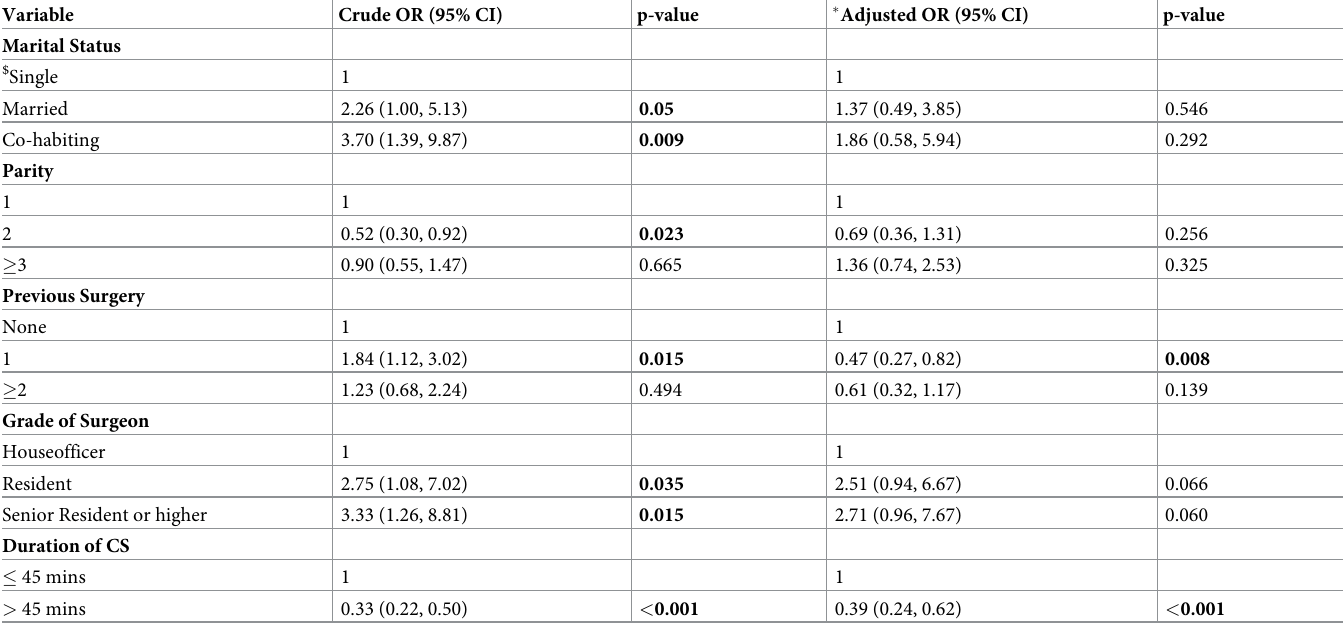
Table 4. Logistic regression analysis output for association with pain scores at 6–12 hours post-CS (rest).